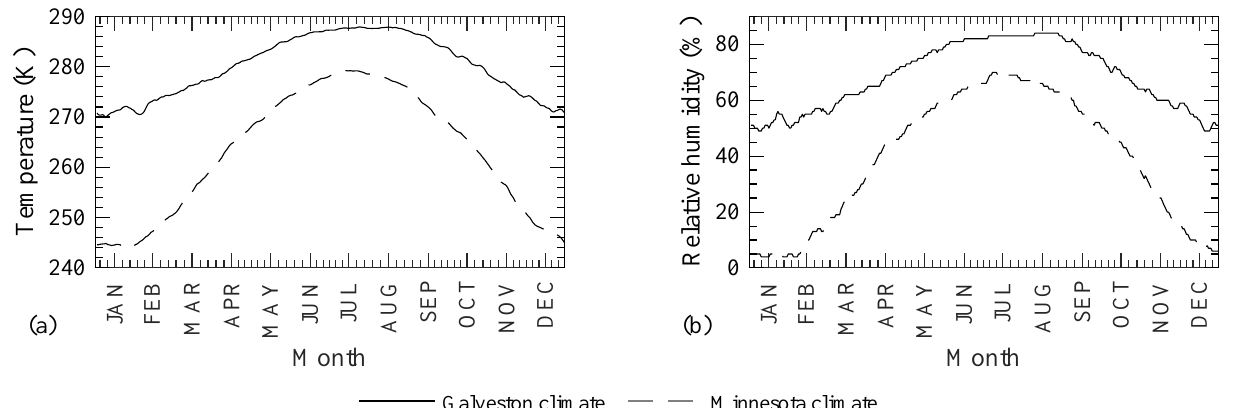
Figure 10. Average weekly temporal variation of ( a ) temperature and ( b ) RH in Galveston, Texas, and North Minnesota, Minnesota (data from [45]).